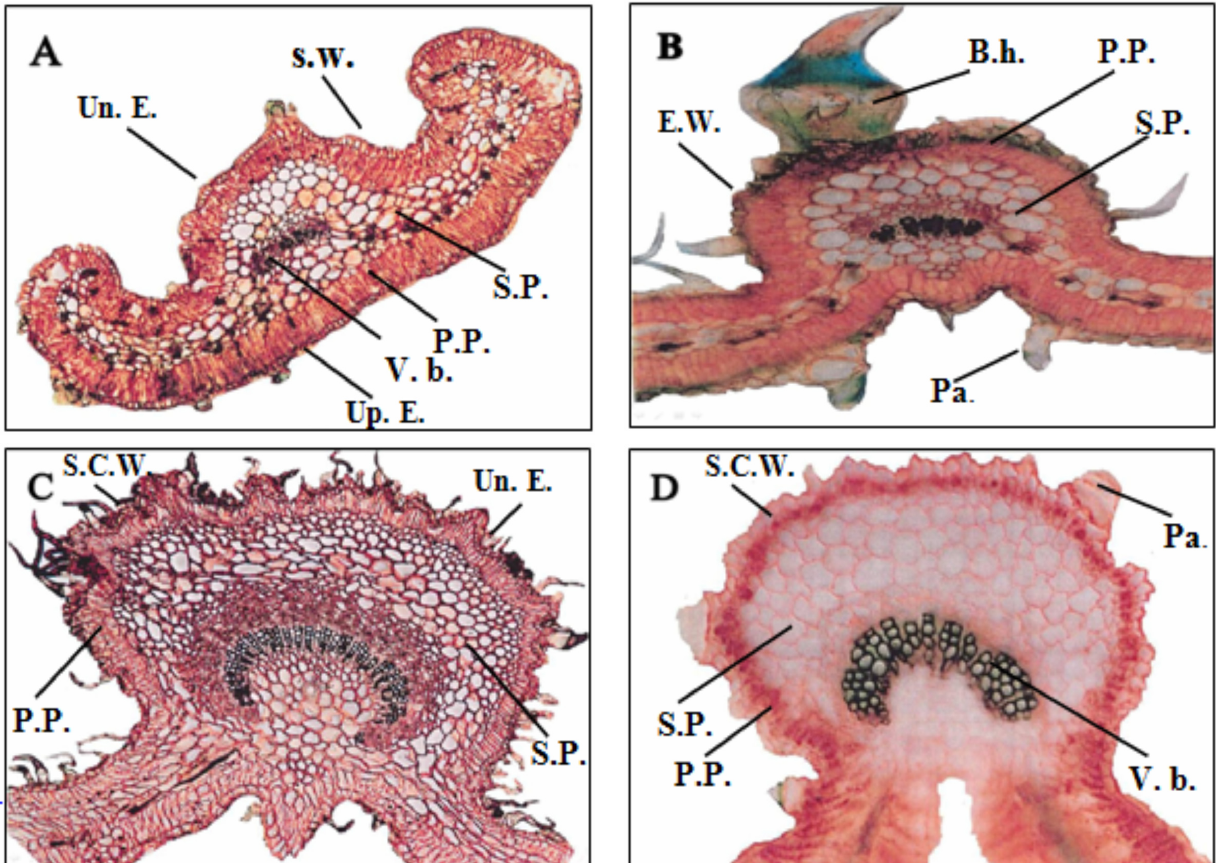
Fig. 1. Midrib of Heliotropium species in T.S; (A) H. bacciferum ; (B) H. ramosissimum ; (C) H. brevilimbe ; (D) H. remotiflurum (Up.E.= Upper Epidermis; Un.E.=Under Epidermis; P.P.=Palisade Parenchyma; S.P.=spongeous Parenchyma; Cu.=Cuticle; B.h.=Bulbous hairs; Pa.=Papilla; S.C.W.=Sinuate Crisped wall; S.W.=Sinuate Wall; E.W.=Entire Wal; V.b.=Vascular bundles;